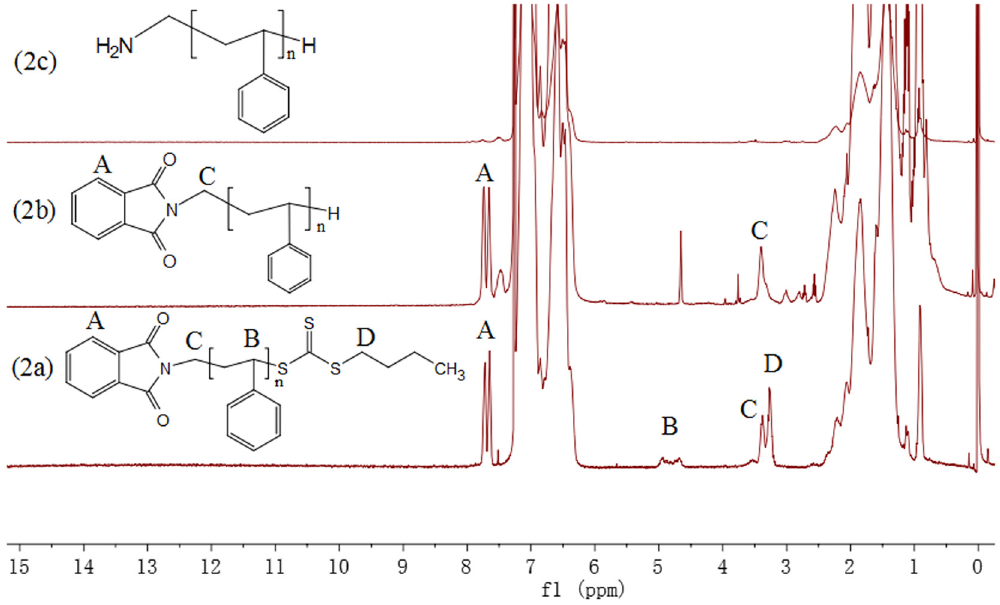
Figure 1: 1 H NMR spectra of 2a , 2b and 2c ; all bands have been characterized in previous papers ( 15 )